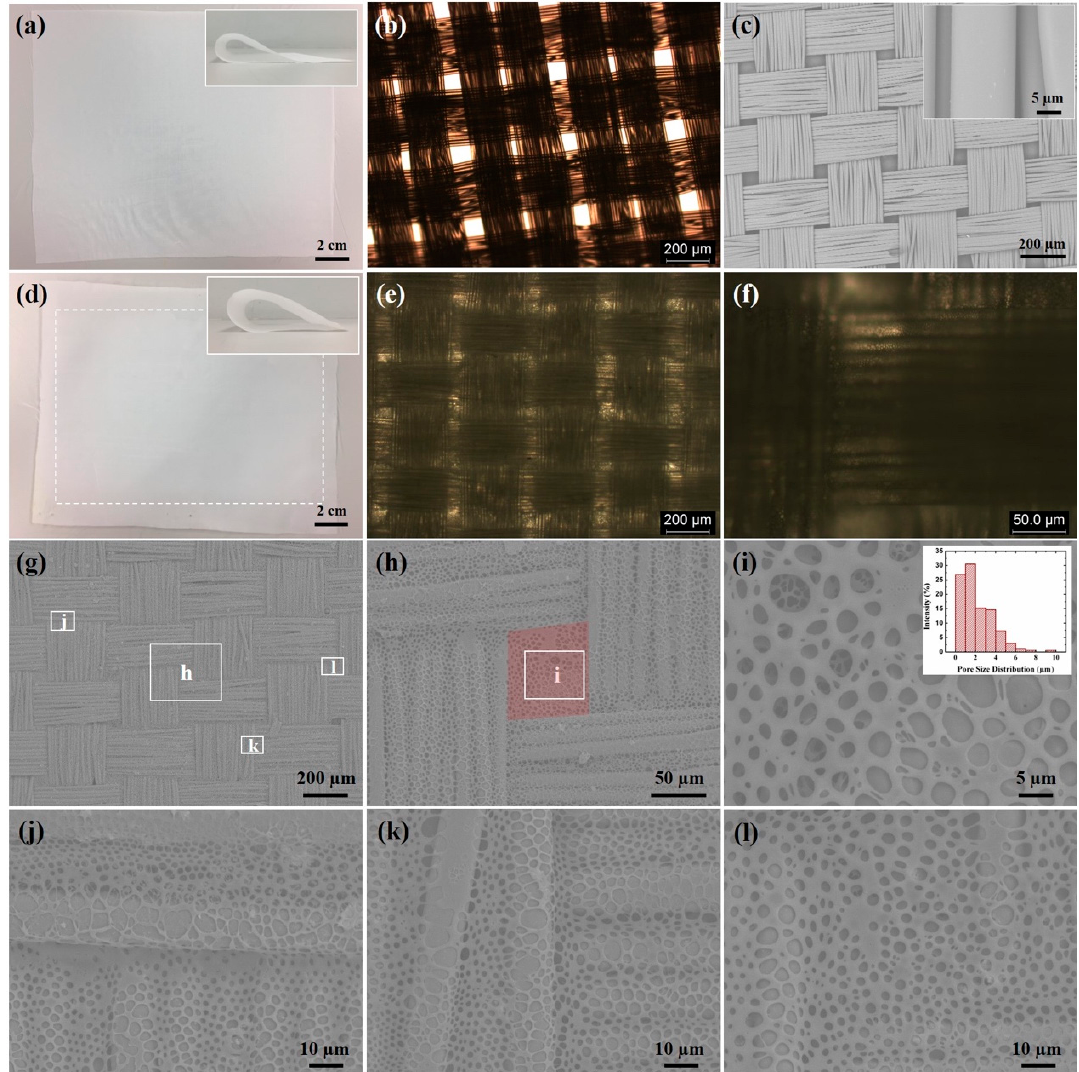
Figure 1. ( a ) Pristine PET fabric and its ( b ) OM and ( c ) SEM images; ( d ) Modified PET fabric after introduction of PS by the BF technique and its ( e , f ) OM images at different magnification and ( g – l ) at different magnification at different areas. The dash frame marked in ( d ) is the modified area of PET fabric; ( h , j – l ) are magnified views of correspondent areas marked with solid frames in ( g ), while ( i ) is the magnified view of marked area in ( h ); The insets of ( a , d ) show the flexibility of PET before and after treatment. The inset of ( c ) shows the close view of unmodified fibers, while the inset of ( i ) shows the pore size distribution.